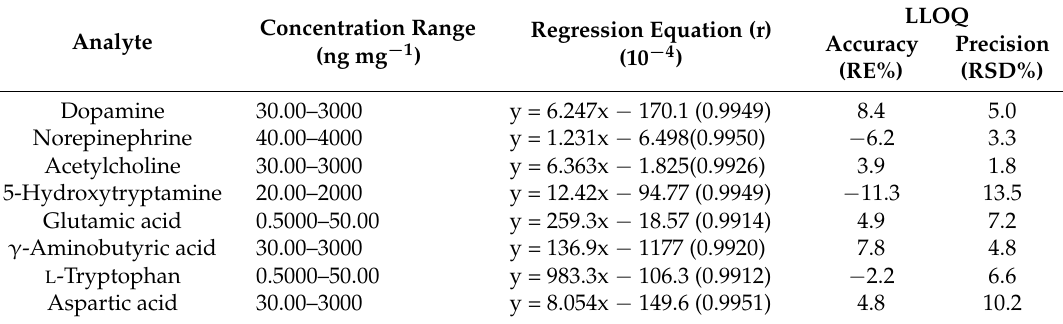
Table 2. The linearity data and lower limit of quantification (LLOQ) with precision and accuracy for analytes in brain using the proposed method.